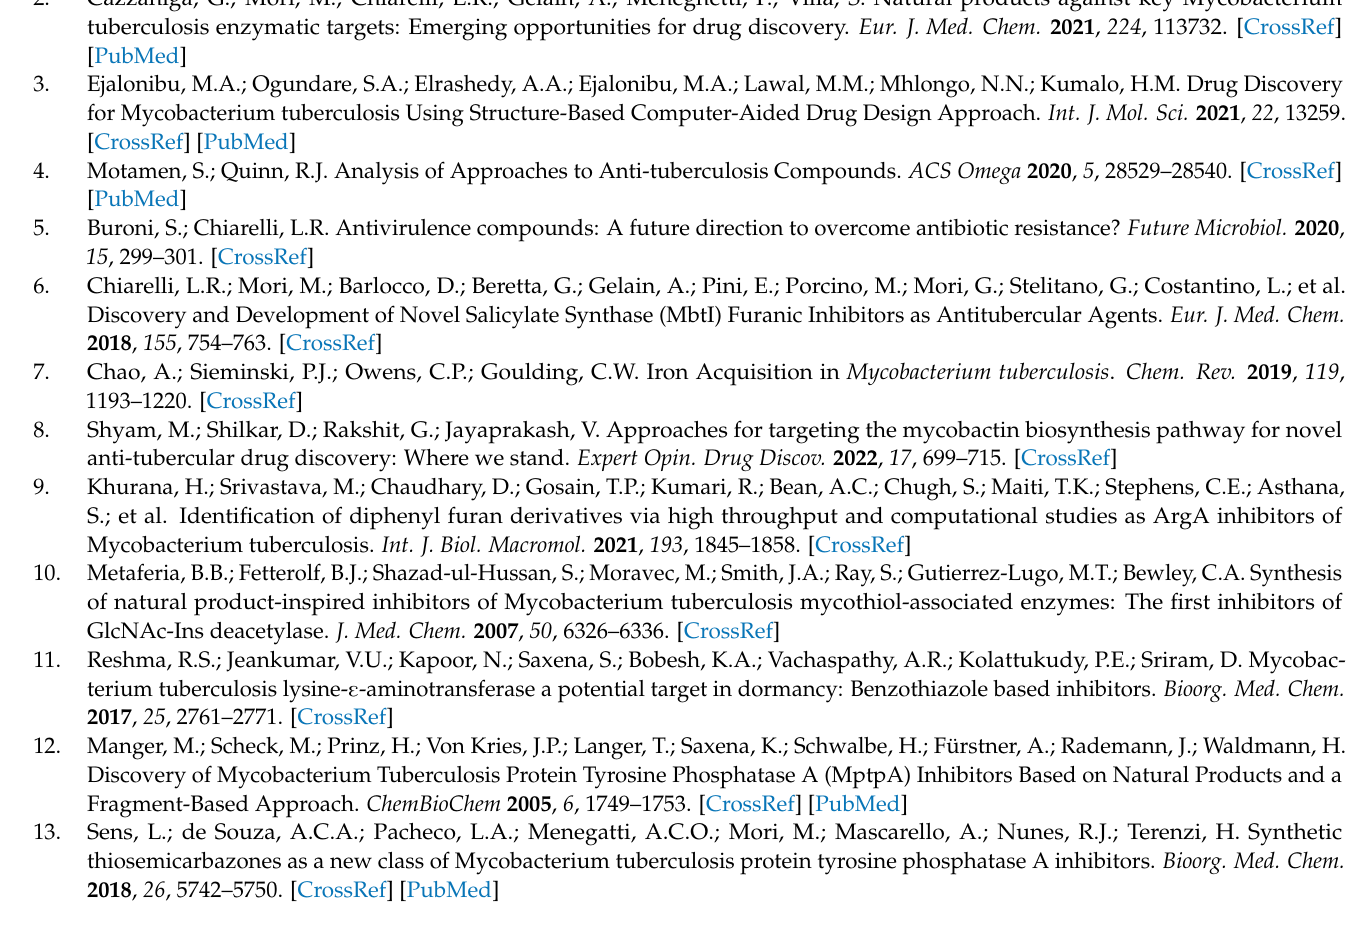
Supplementary Materials: Table S1. Atomic coordinates and equivalent isotropic displacement parameters. Table S2. Bond lengths [Å] for 1 . Table S3. Bond angles [ ◦ ] for 1 . Table S4. Anisotropic displacement parameters. Figure S1. 1 H NMR spectrum of 2 . Figure S2. 13 C NMR spectrum of 2 . Figure S3. 1 H NMR spectrum of 1 . Figure S4. 13 C NMR spectrum of 1 . Figure S5. HRMS spectra of 1